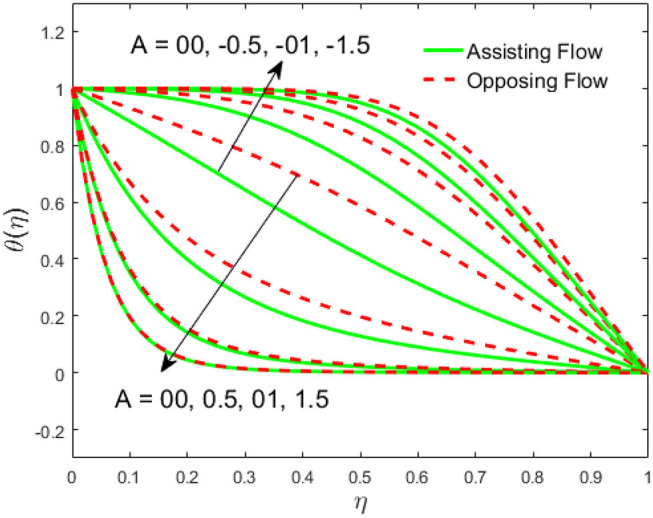
Impact of A on θ(η).